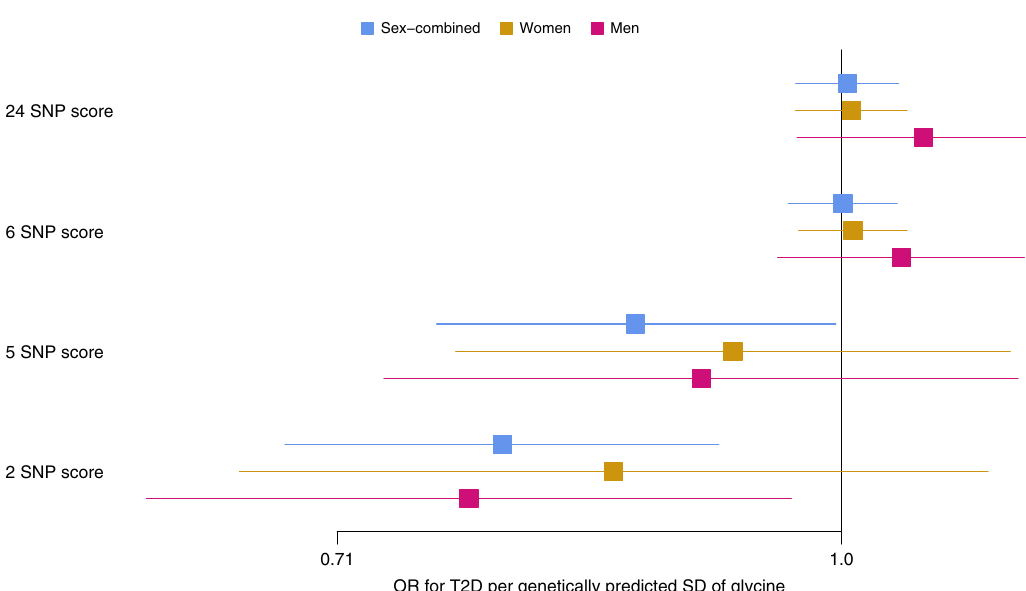
Fig. 8 Forest plot of the odds ratios ± 95% con fi dence intervals for type 2 diabetes per standard deviation genetically predicted higher levels of glycine using four different genetic scores for glycine. Genetic estimates are based on 74,124 T2D cases and 824,006 controls for sex-combined analyses. Sex- speci fi c genetic analyses include 12,013 female and 16,914 male T2D cases and 202,124 female and 164,944 male controls. For the sex-speci fi c analyses, the standard deviations of the sex-speci fi c glycine distributions were used, which were 0.321 and 0.195 (arbitrary units) for women and men in the EPIC- Norfolk study, respectively. Results based on the weighted median MR method are shown